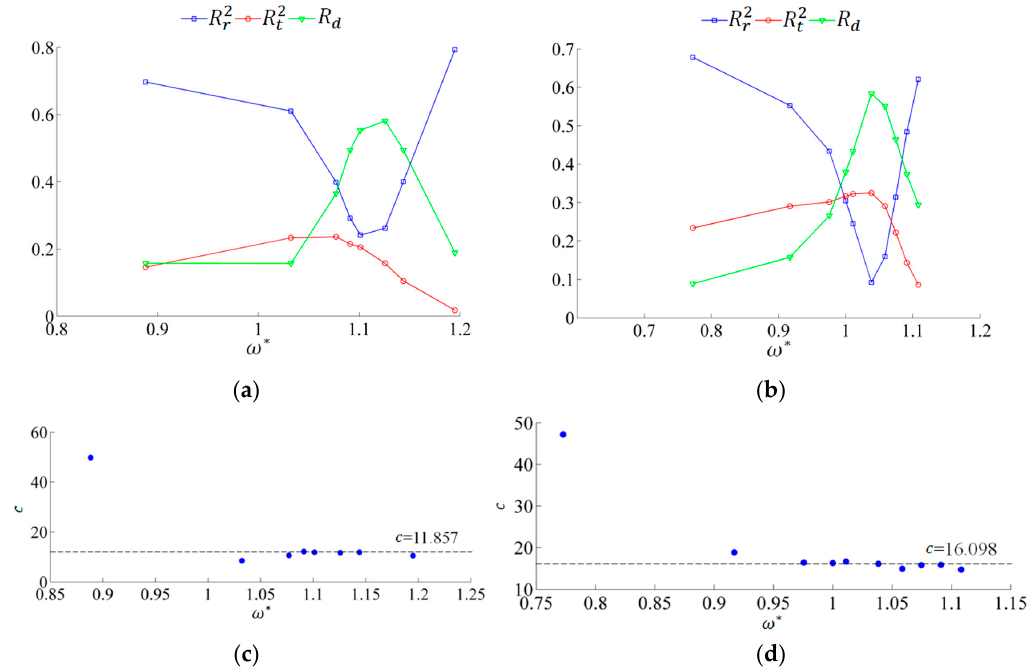
Figure 18. The resonance frequency 𝜔 (cid:3041)∗ and the dimensionless added mass 𝑚 (cid:3028) /[𝜌𝐵𝐵 (cid:3034)(cid:2870) /(ℎ − 𝑑)] decreases with the increase of the gap width 𝐵 (cid:3034)∗ .